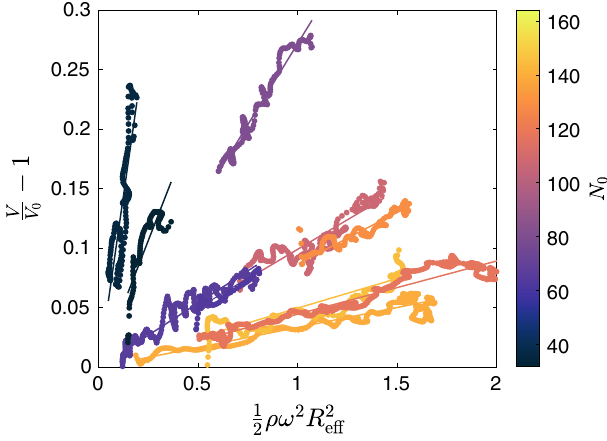
FIG. 6. Example raw data for the calculation of K (dots). The fractional change in volume of the raft V=V 0 − 1 is plotted as a ρω 2 R 2 function of the rotational pressure, 1 . Color indicates N 0 . 2 eff The best-fit line is indicated as a solid line through each data set. Data have been smoothed with a moving average filter, with a width of 10 data points (3